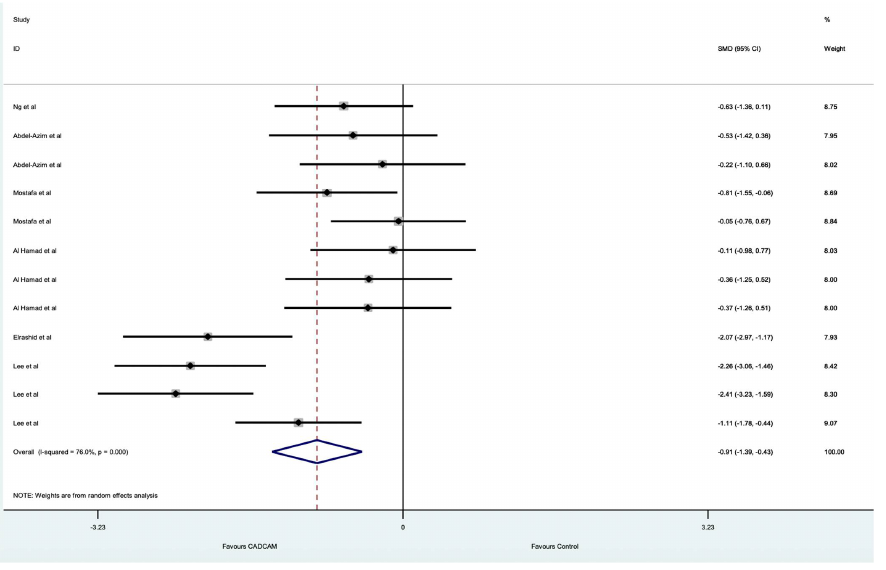
Figure 5. Forest plot comparing the included studies investigating the inter-proximal marginal fit of crowns. of